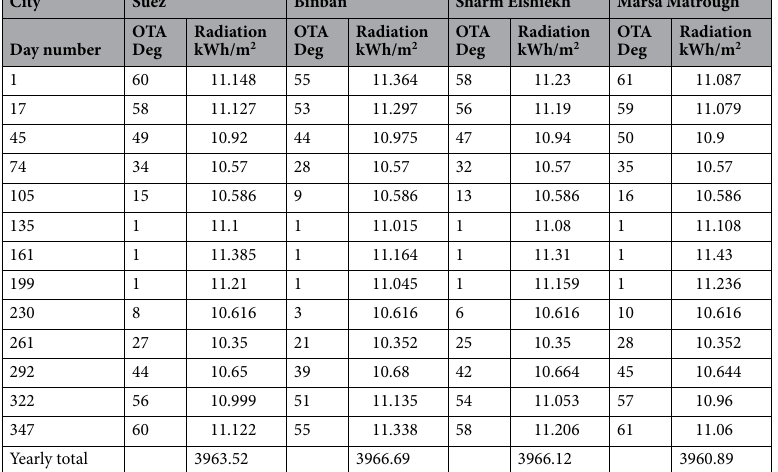
Table 1. Optimal daily angle and radiation.